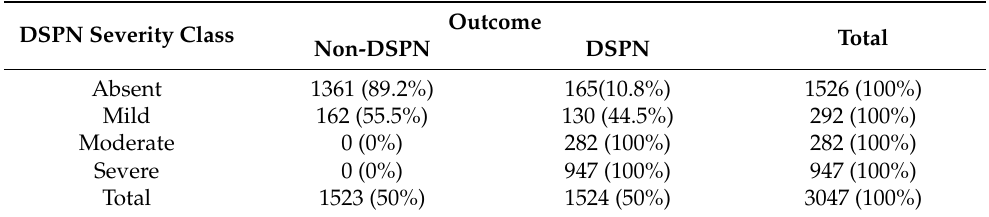
Table 7. The association among different DSPN severity groups and the actual outcomes in the EDIC training dataset, utilizing the Fisher exact probability test.